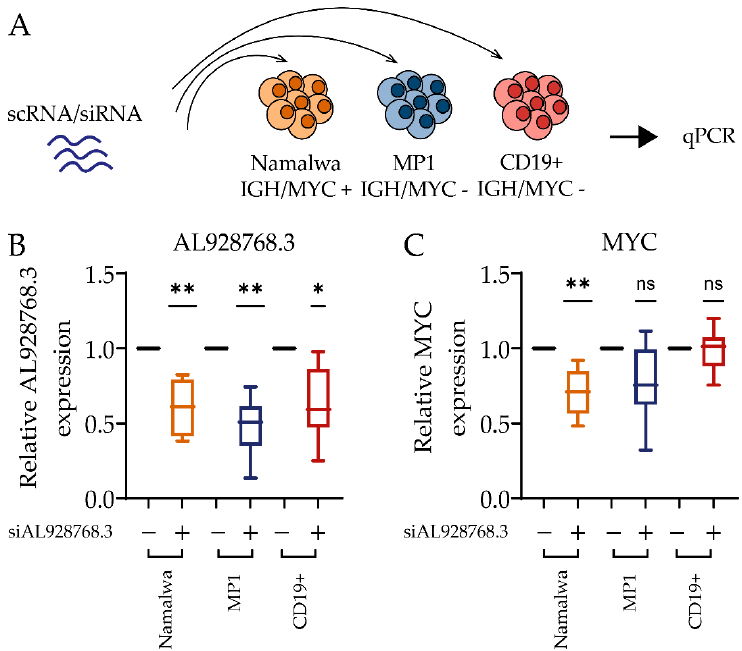
Figure 4. The siRNA-mediated knockdown of AL928768.3. ( A ) The scheme of the experiment. Cells were electroporated with siRNA targetingAL928768.3 (+) or scRNA as a control ( − ). Expression data were normalized on values in control samples. The diagrams demonstrate relative AL928768.3 ( B ) and MYC ( C ) expression. * p -value less than 0.05; ** p -value less than 0.01, ns—no significant difference (Wilcoxon test). The number of independent experiments: Namalwa (n = 8); MP1 (n = 8); CD19+ primary B cell (n = 6).